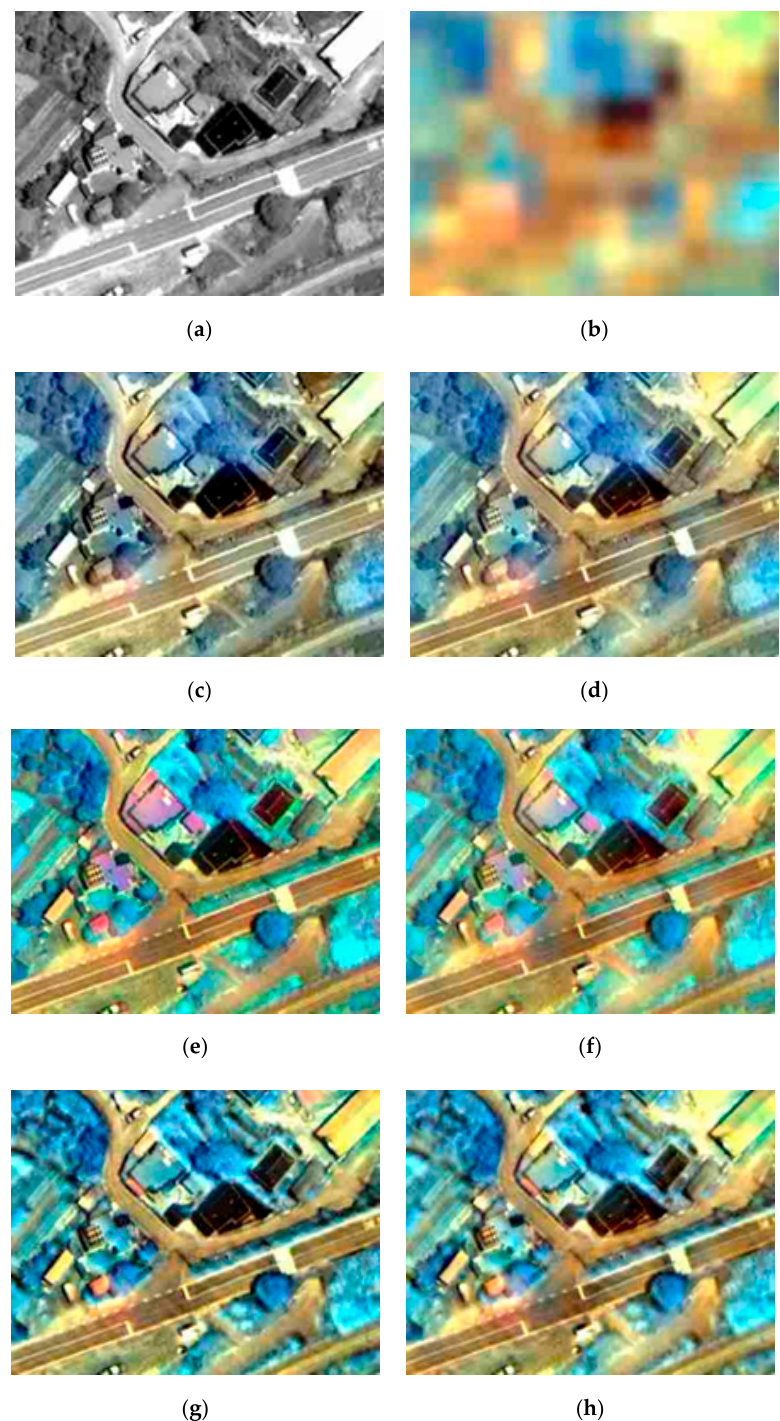
Figure 5. Pansharpening results of SWIR bands for site 2 (SWIR bands 8, 4, and 1 are shown as RGB): ( a ) panchromatic image; ( b ) original SWIR image; ( c ) GSA result from the existing method; ( d ) GS2 result from the existing method; ( e ) GSA result from the proposed algorithm based on the selected band scheme; ( f ) GS2 result from the proposed algorithm based on the selected band scheme; ( g ) GSA result from the proposed algorithm based on the synthesized band scheme; ( h ) GS2 result from the proposed algorithm based on the synthesized band scheme.